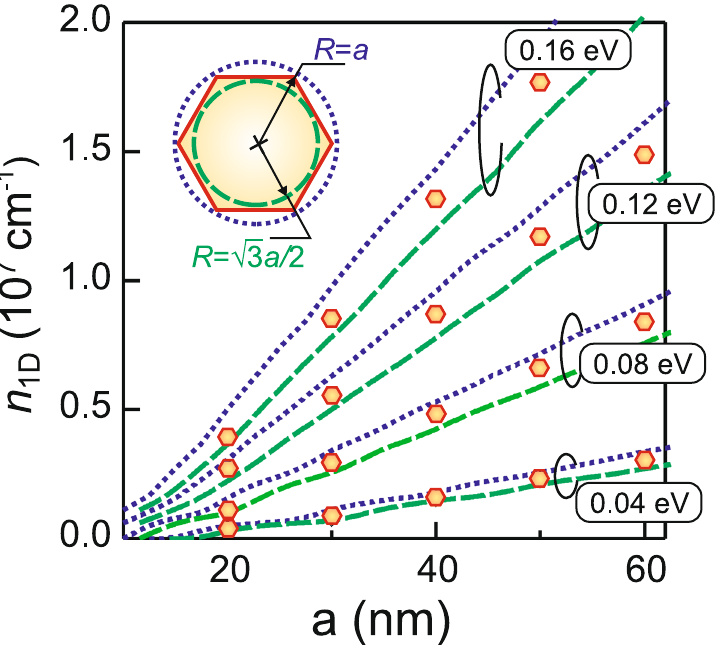
Figure 7. One-dimensional electron density calculated for the InAs nanowire with the hexagonal cross- section (symbols) and the circular cross section as a function of the nanowire side length plotted for the various position of the Fermi level with respect to the conduction band edge at the surface for the lattice temperature T = 4 K; the circular cross section corresponds to the circle circumscribed about (dotted line) and inscribed in (dashed line) the hexagon